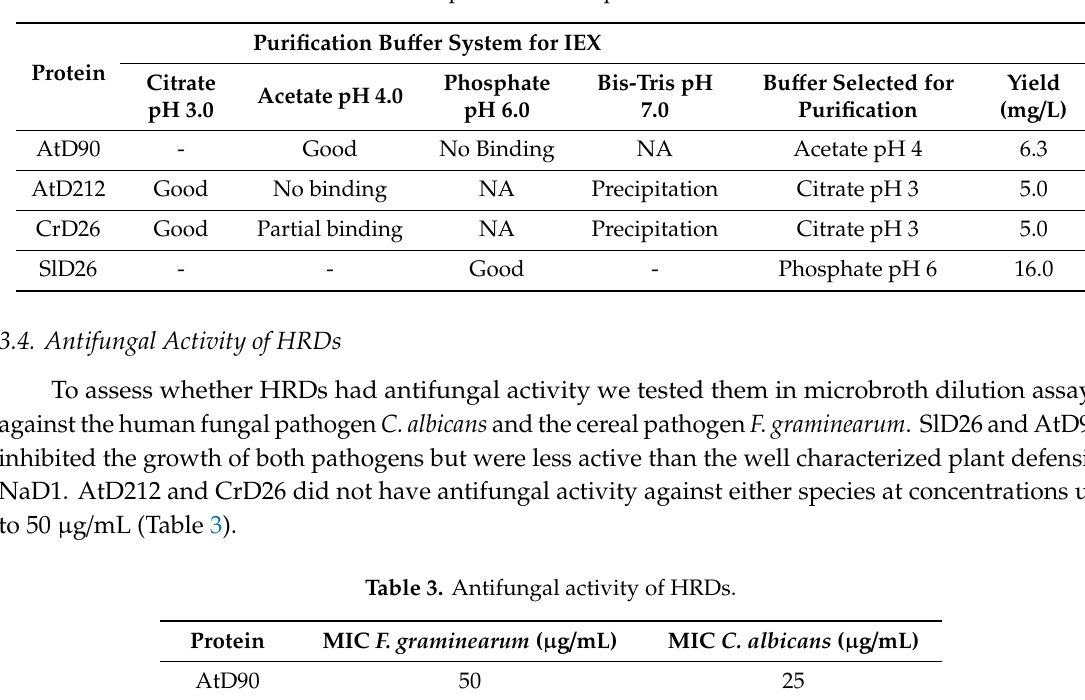
Table 2. Bu ff er optimization for purification of HRDs.